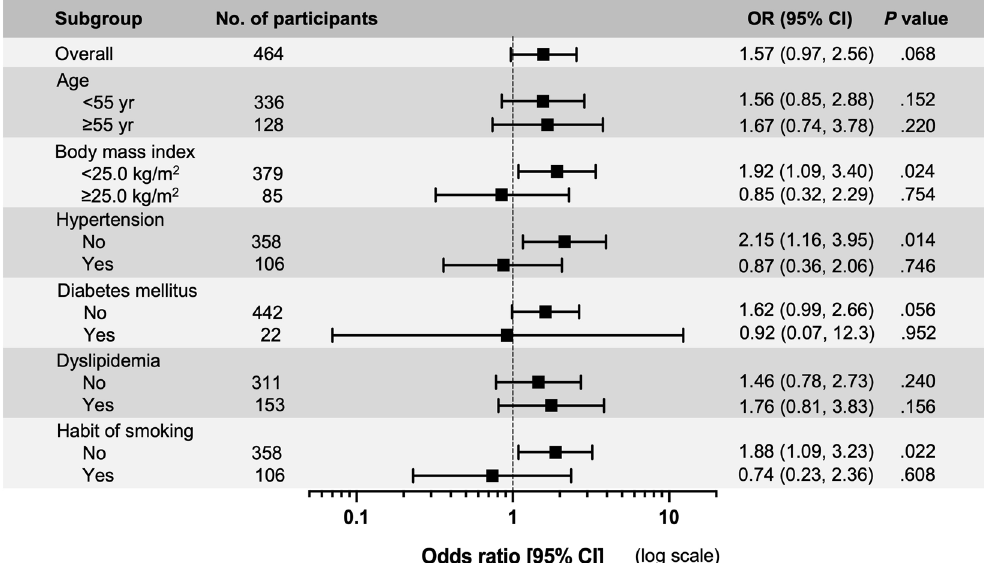
Figure 2. Risk of high-level FIB-4 score for incident chronic kidney disease after a 5-year follow-up. Odds ratios (OR) were calculated after propensity score matching. Hypertension was defined as systolic blood pressure ≥ 140 mmHg, diastolic blood pressure ≥ 90 mmHg, and/or the use of antihypertensive medication. Diabetes mellitus was defined as a hemoglobin A1c level ≥ 6.5% and/or the use of anti-diabetes mellitus medicine, including insulin. Dyslipidemia was defined as a triglyceride level ≥ 150 mg/dL and/or low-density lipoprotein cholesterol level ≥ 140 mg/dL.